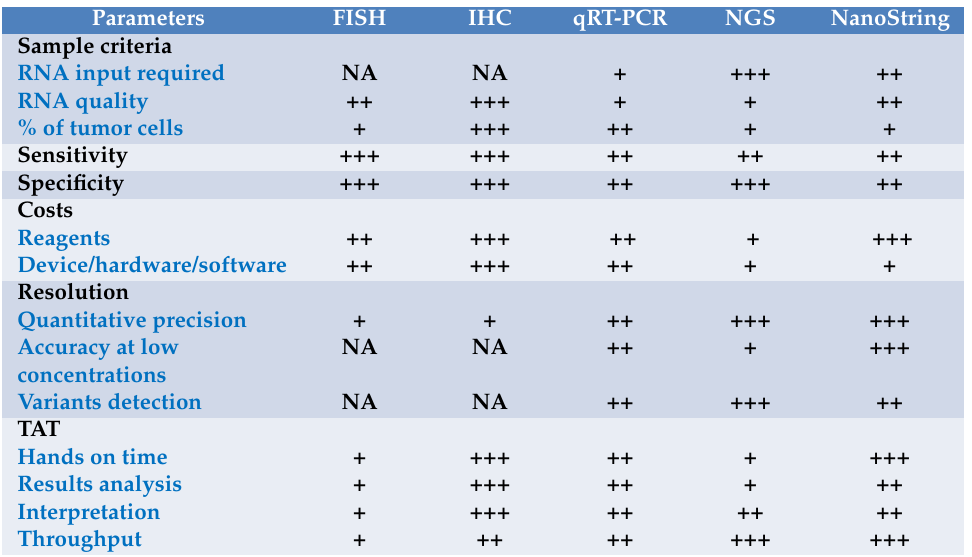
Table 1. Comparison of different methods for ALK testing in tissue